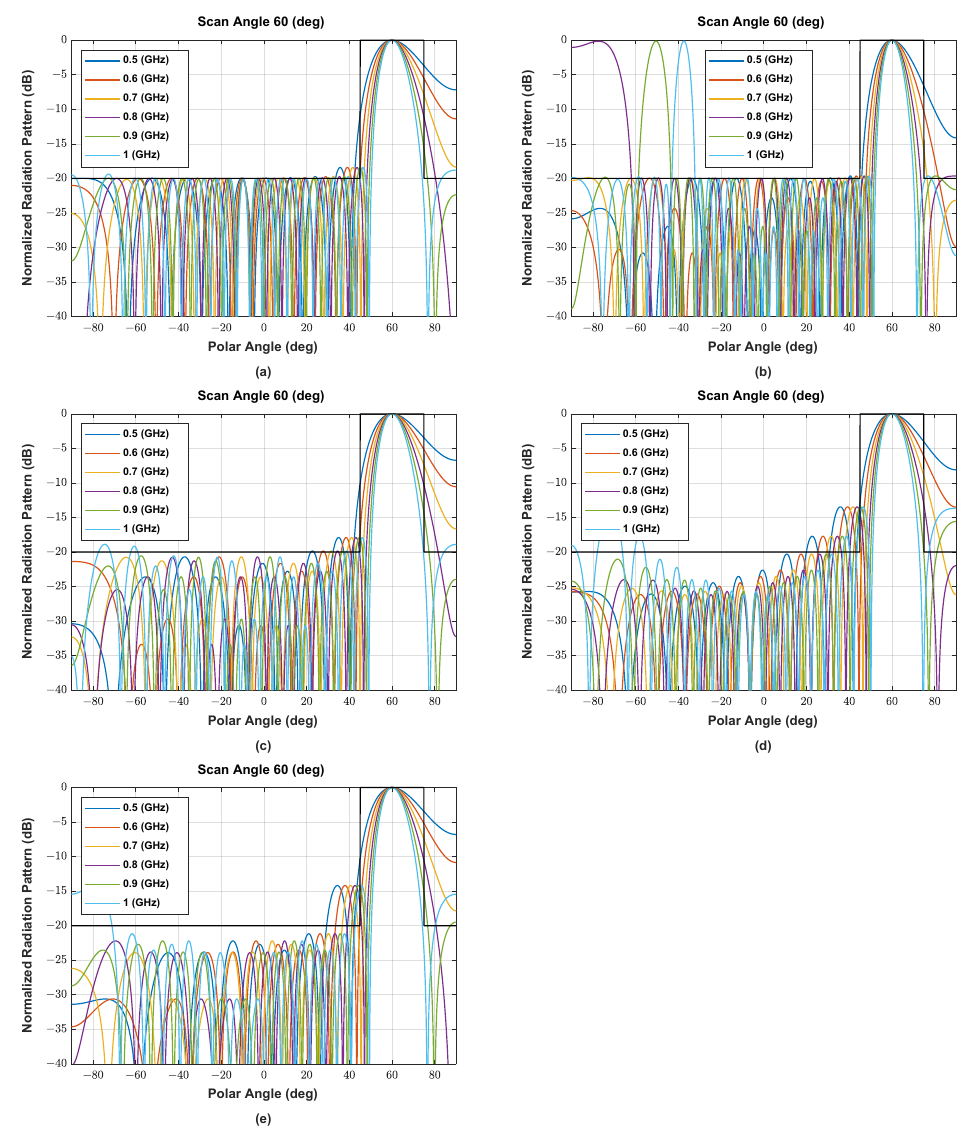
Figure A3. The beam pattern of symmetric NUSLA using ( a ) MORELA, ( b ) QPSO, ( c ) FA, ( d ) SSA, and ( e ) MALO in case for θ 0 =